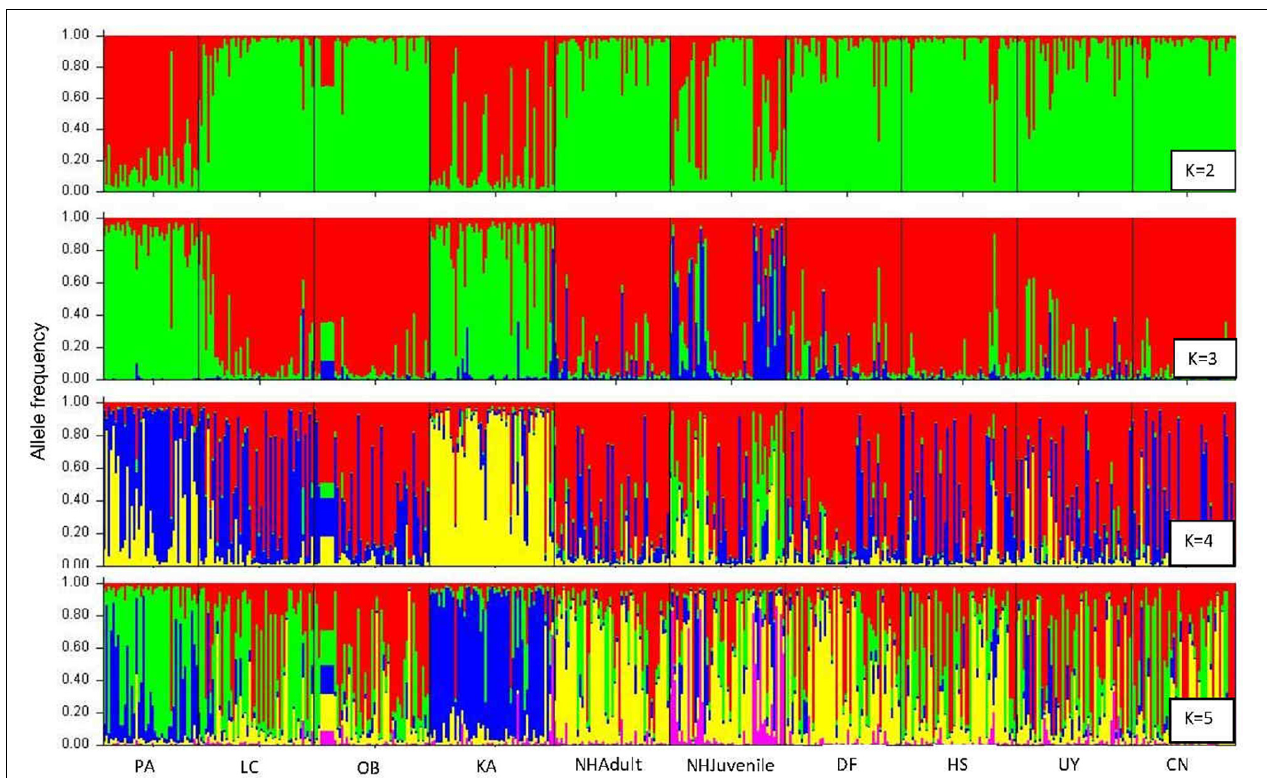
FIGURE 4 | STRUCTURE output with K = 2–5 for M. modiolus reef populations across Scottish regions. Population codes provided along x -axis. Populations showing the same color are part of the same genetic group (K). Population codes as per Table 1